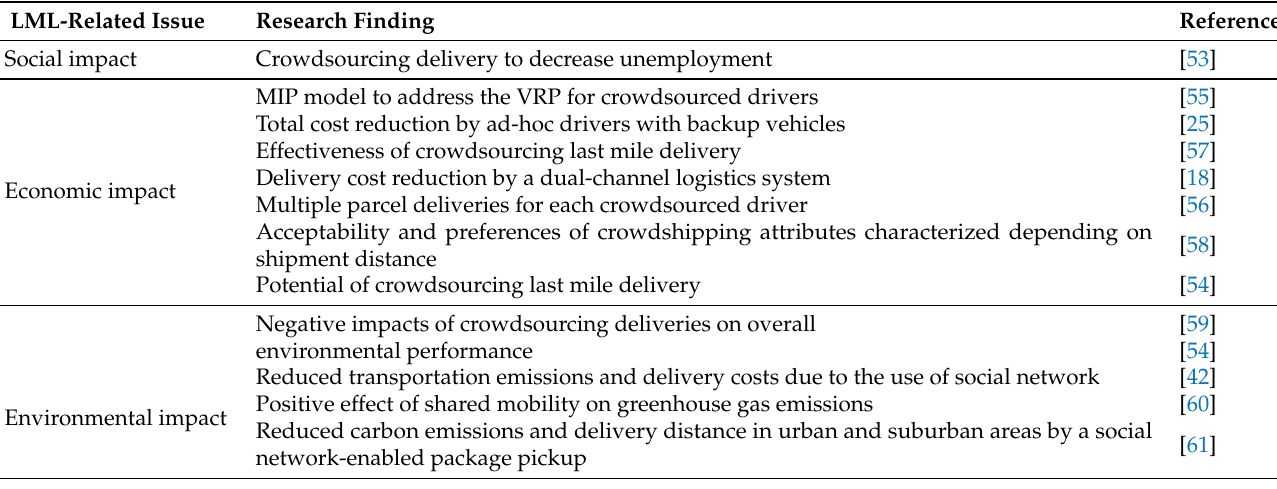
Table 3. LML-related issues and research findings: Sharing